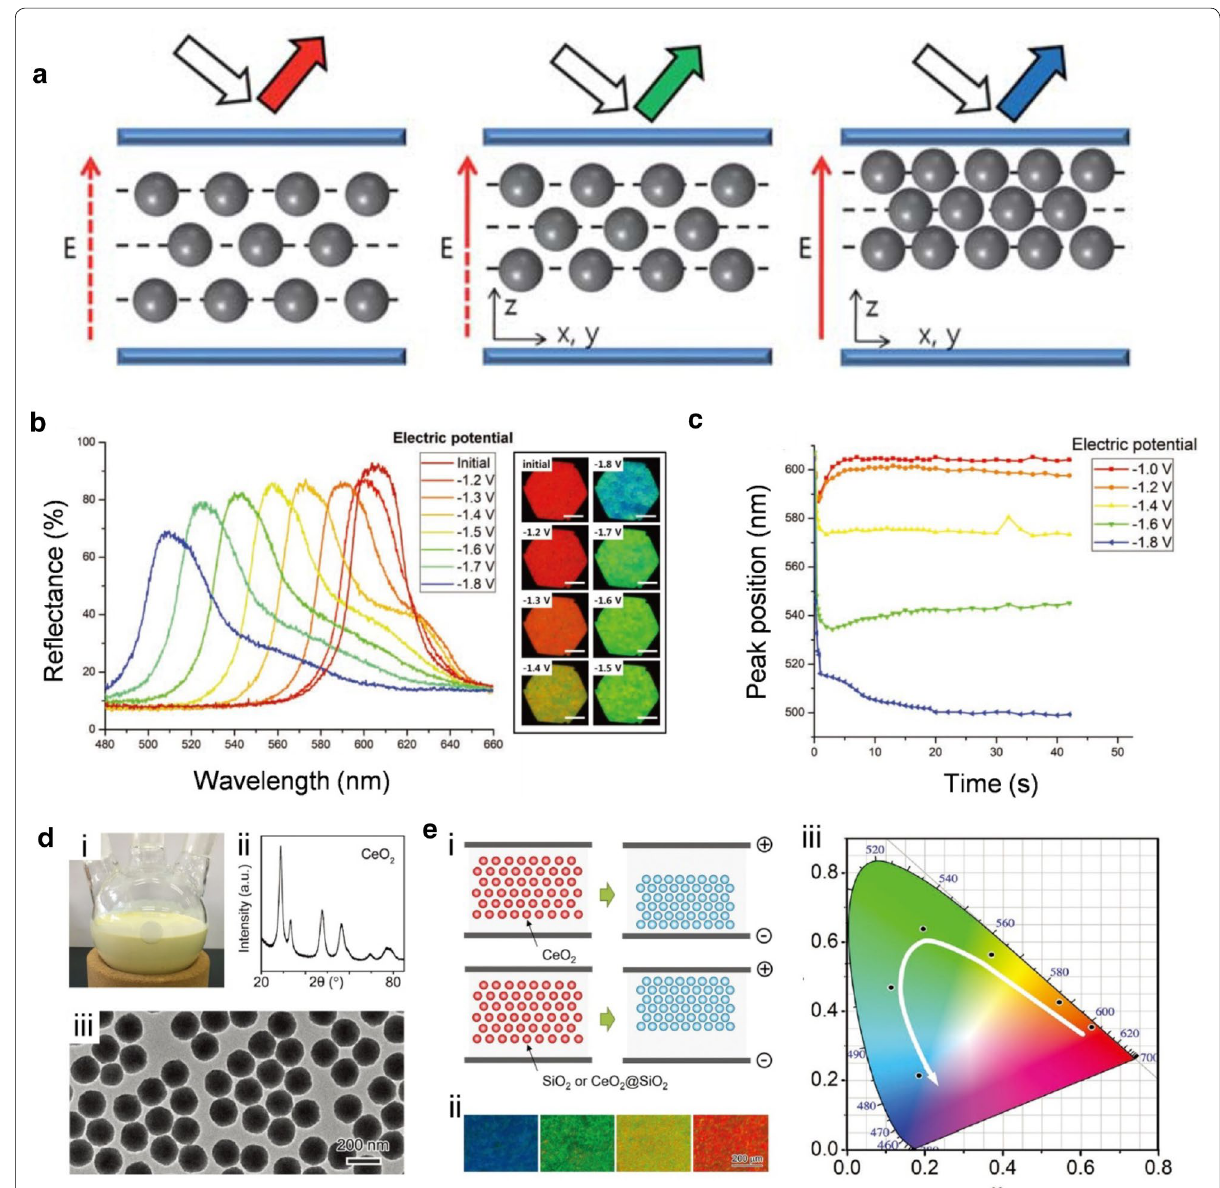
Fig. 10 Electrokinetic driven 3D photonic crystals a Schematic representation of the changes in an array of charged particles under different electric fields. b Changes in reflective colors exhibited by a single device with various voltage bias. c Profiles of peak reflectance as a function of time under different DC bias excitation. d (i) A digital photo of CeO 2 particles. (ii) a X‑ray diffraction pattern of CeO 2 particles. (iii) a TEM image of